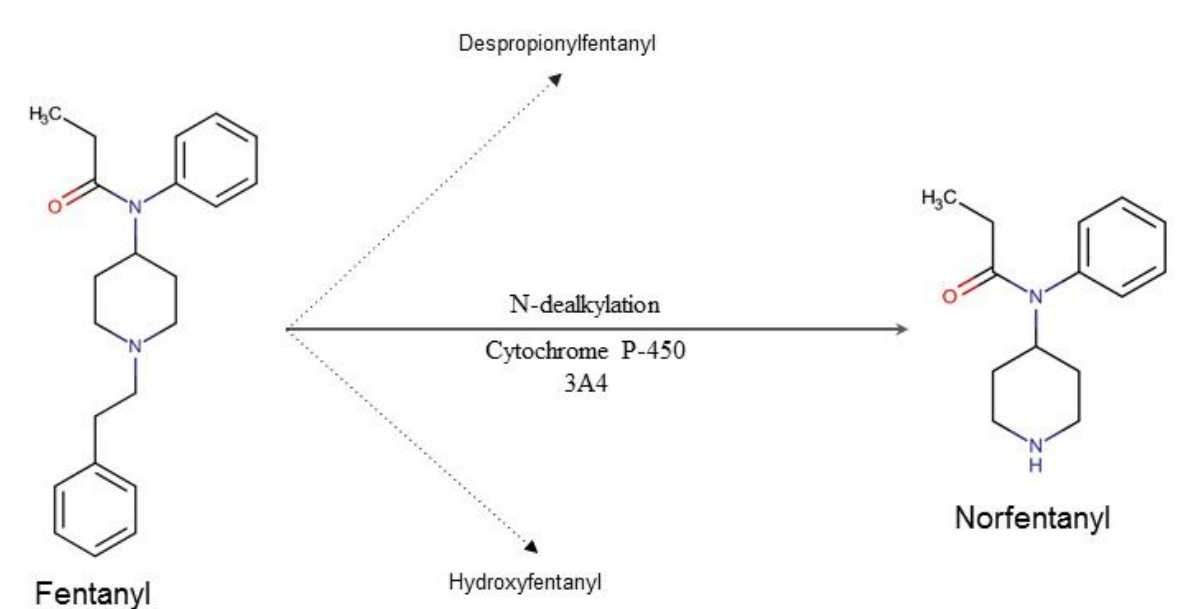
Figure 1. Fentanyl’s metabolic pathway in humans. Ninety-nine percent of the metabolized fentanyl is converted into norfentanyl. The remaining 1% is converted to despropionyl fentanyl and hydroxyfentanyl.